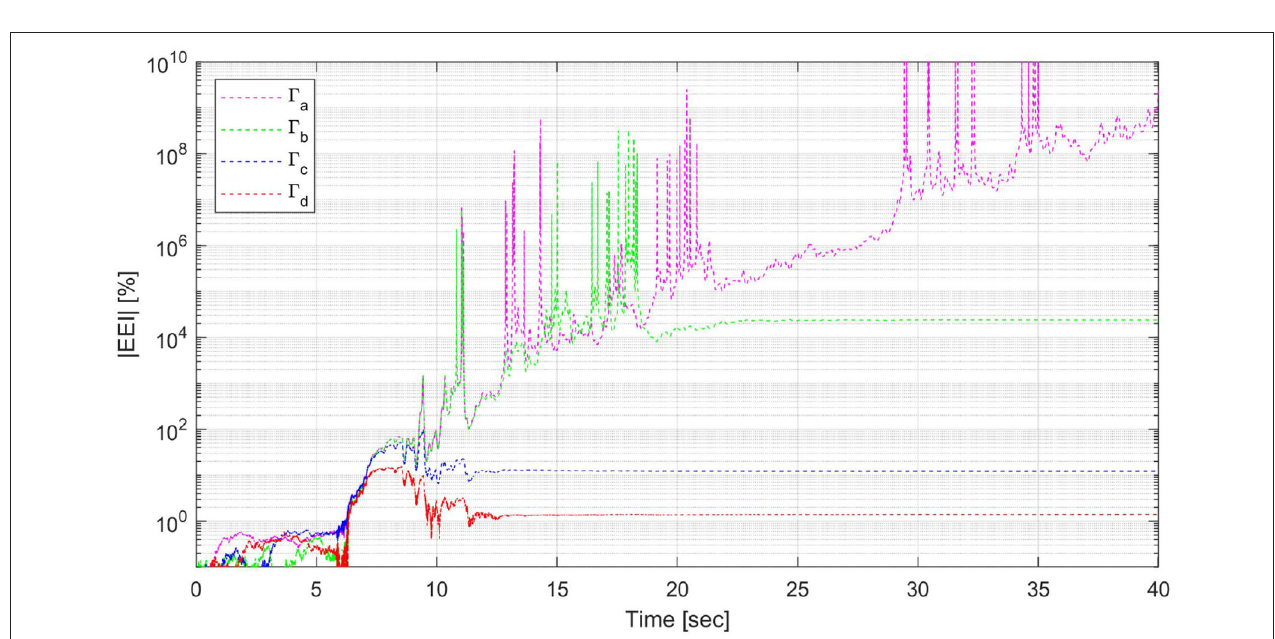
FIGURE 13 | Stability warning indicator (SW) for different adaptive gains.